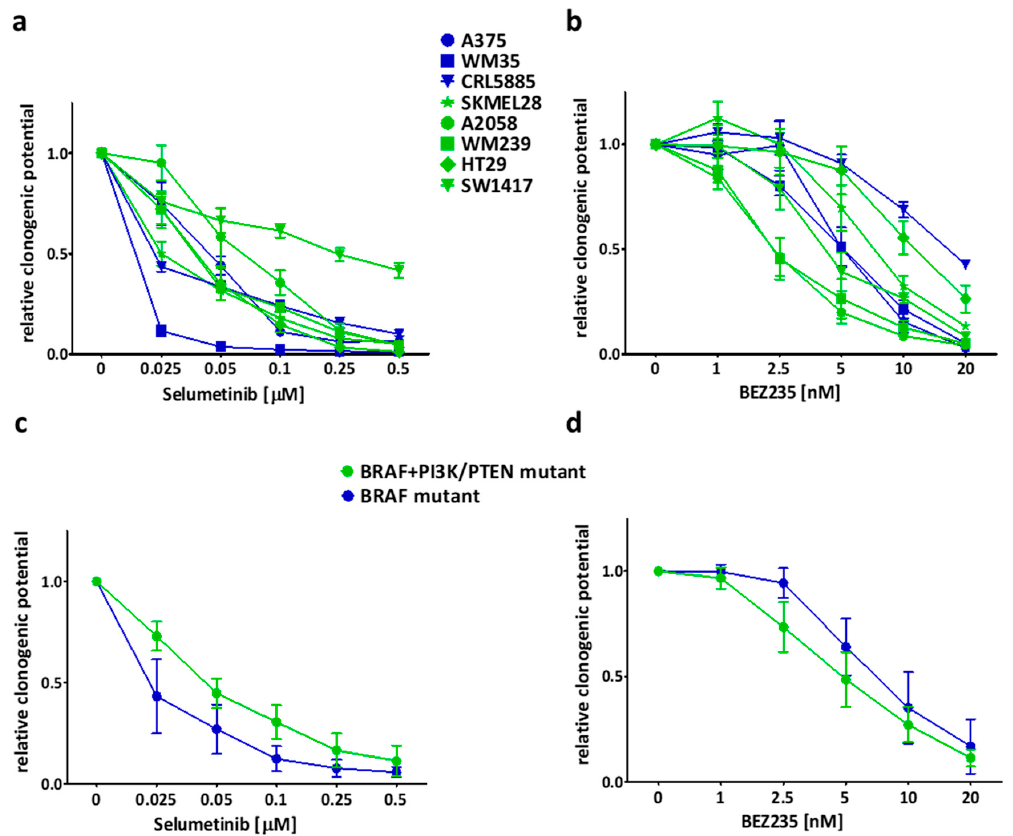
Figure 2. Colony formation inhibitory e ff ect of selumetinib and BEZ235 for 10 days. ( a , b ) BRAF mutant (blue marked) cell lines were more sensitive to selumetinib than the BRAF + PI3K / PTEN mutant (green) cells; on the other hand, BEZ235 inhibited the cell lines with BRAF + PI3K / PTEN mutation more e ff ectively than the BRAF mutant cell lines. ( c , d ) Average clonogenic potential in the mutational groups after treatment with selumetinib or BEZ235. Data is shown the mean ± SEM from at least three independent experiments.